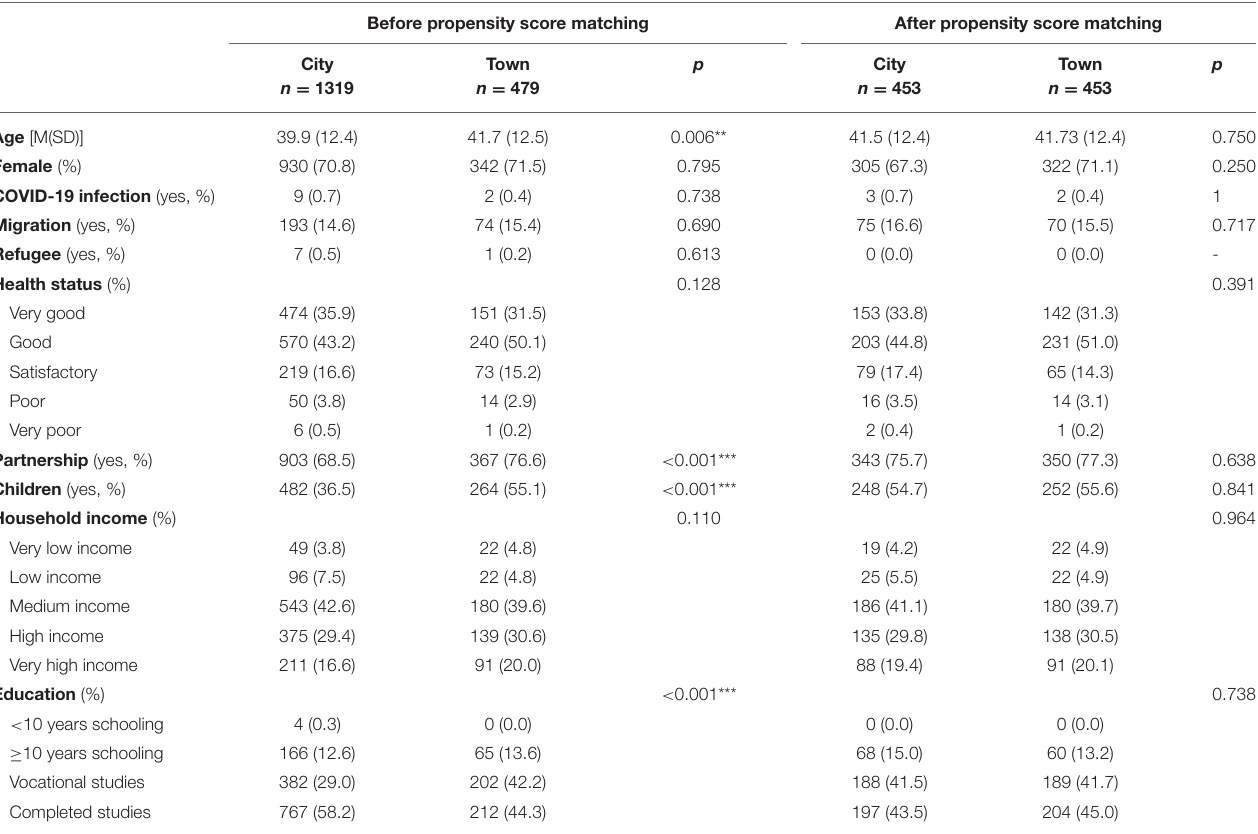
TABLE 1 | Covariates before and after propensity score